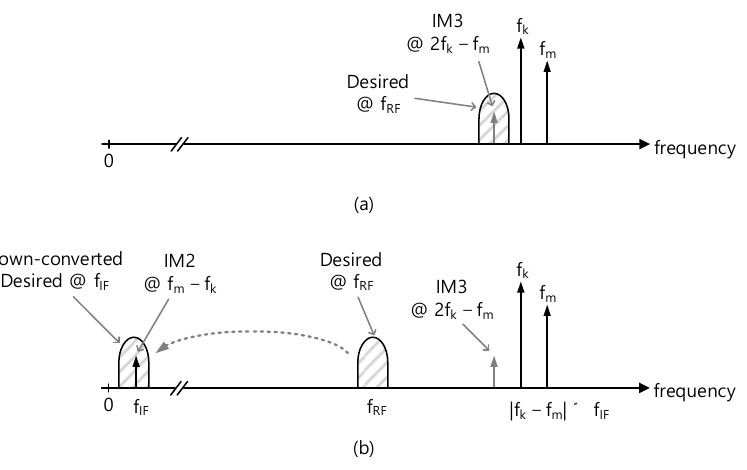
Figure 1. Two-tone blocker effects. ( a ) Third-order intermodulation effect for the close-in blocker, ( b ) second-order intermodulation effects for the far-out blocker.